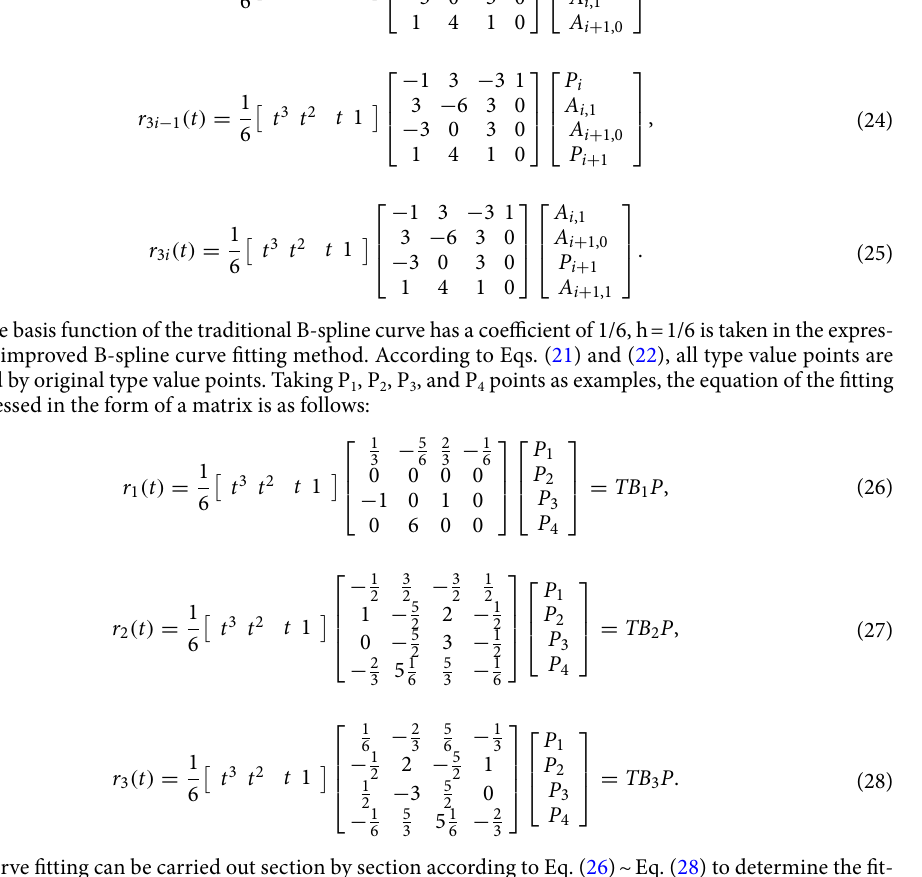
B-spline curve fitting algorithm is based on the basis function of the B-spline curve fitting algorithm, the inter- polation curve not only has the advantages of the local, continuous and convex hull of the traditional B-spline curve but also improves the curve fitting accuracy through all the original type value